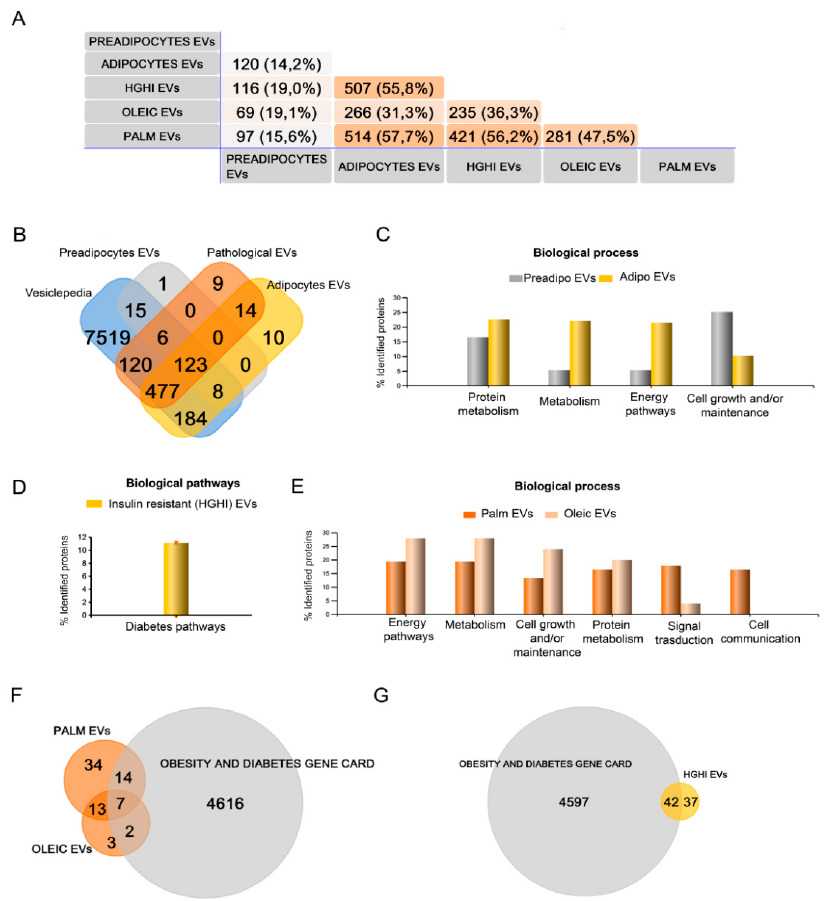
Figure 2. Qualitative (DDA) mass spectrometry analysis shows that extracellular vesicles (EVs) protein cargo varies with lipid hypertrophy and insulin resistance. EVs isolated from non-di ff erentiated and di ff erentiated adipocytes as control, and also from those treated with palmitate (500 µ M, 18 h), oleic acid (1 mM, 48 h), and high glucose (4.5 g / L) / high insulin (5 µ g / mL, 48 h) treatment (HGHI) were analyzed by mass spectrometry. A descriptive Venn diagram showing the overall number of proteins identified with an FDR < 1% (99% protein confidence) in vesicles isolated from preadipocytes, control di ff erentiated adipocytes, and those from the three pathological cell models (HGHI, palmitate and oleic acid hypertrophy) ( n = 4 independent experiments considering only those proteins present in 3 out 4 samples) ( A ). All identified proteins were also compared to the Vesiclepedia database ( B ). Funrich functional analysis classification of identified proteins by biological process and pathways is shown (percentages per annotated genes in each class; number of genes in background) for vesicles isolated of pre- and mature adipocytes ( C ); of HGHI ( D ), and of palmitate and oleic acid treated cells ( E ). Venn diagrams comparing the Obesity and Diabetes Gene card database to those proteins exclusively identified (not present in EVs shed by control di ff erentiated cells) in EVs from lipid hypertrophied ( F ) and HGHI ( G ) treated